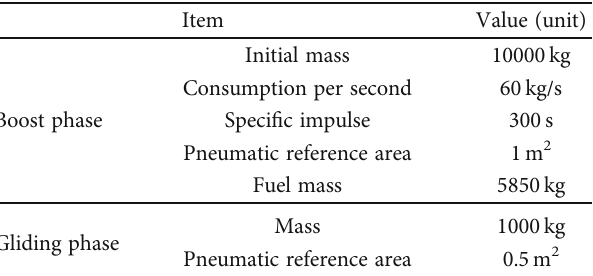
Table 5: General parameters of the